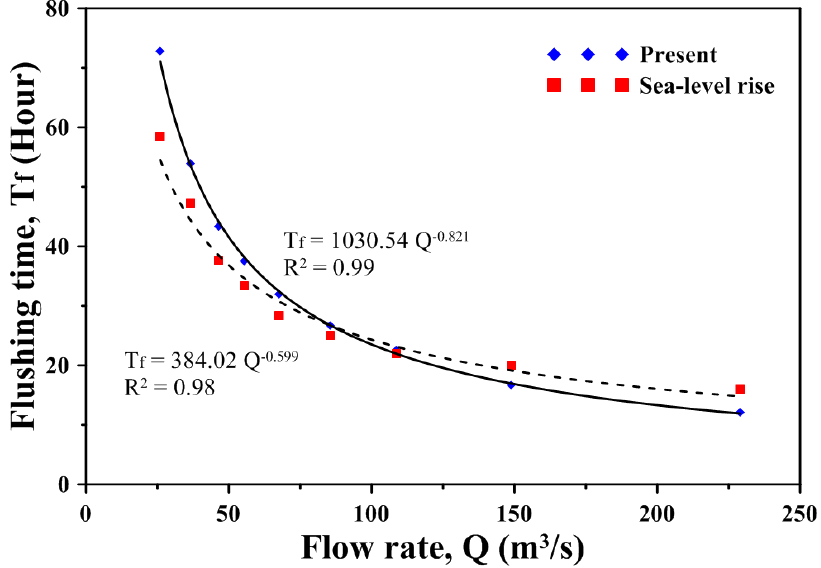
Figure 12. Regression between flushing time and freshwater input for the present condition and the sea level rise